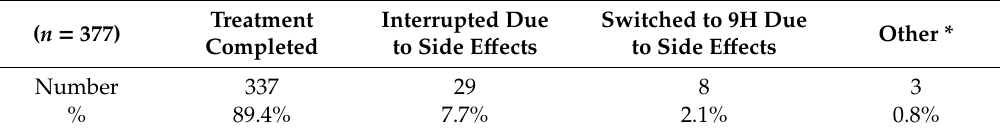
Table 1. Characteristics and treatment outcomes of the enrolled